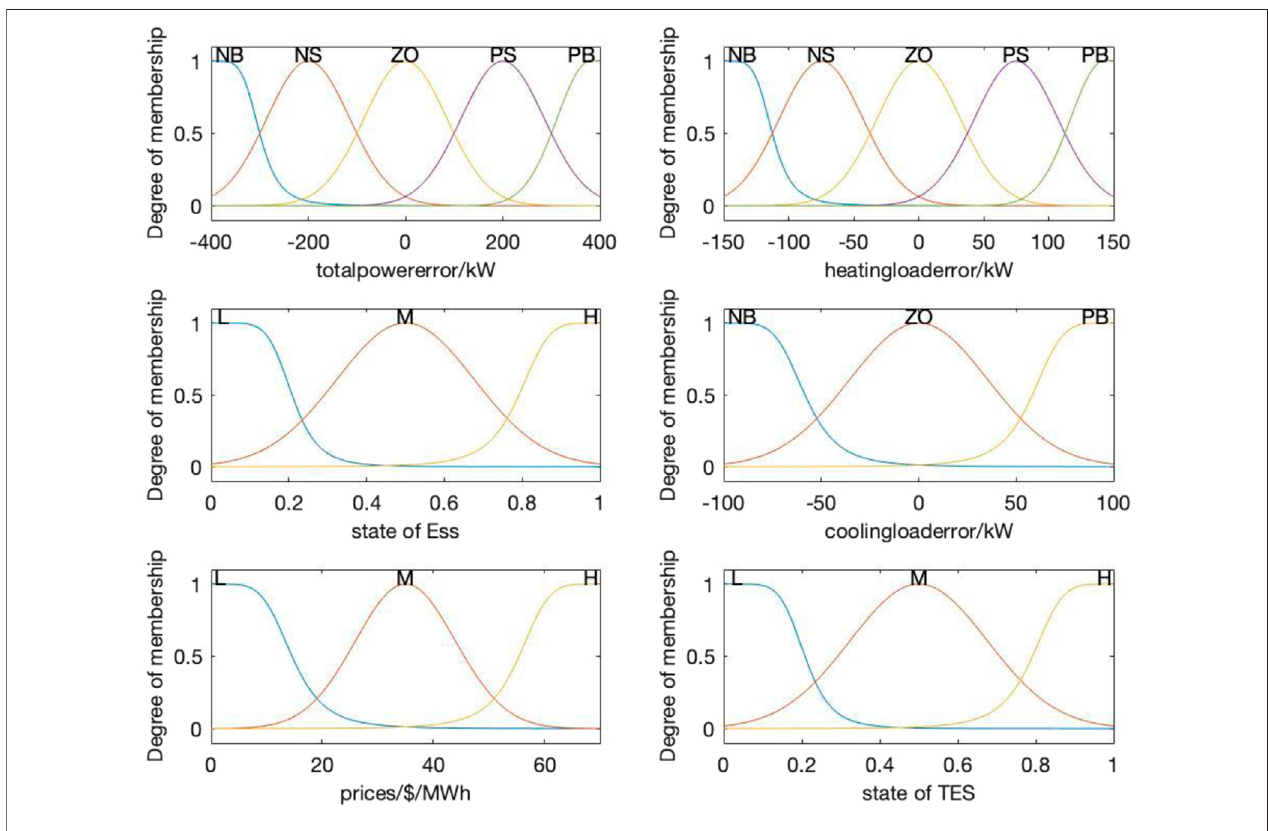
FIGURE 4 | Control surface of the TES system